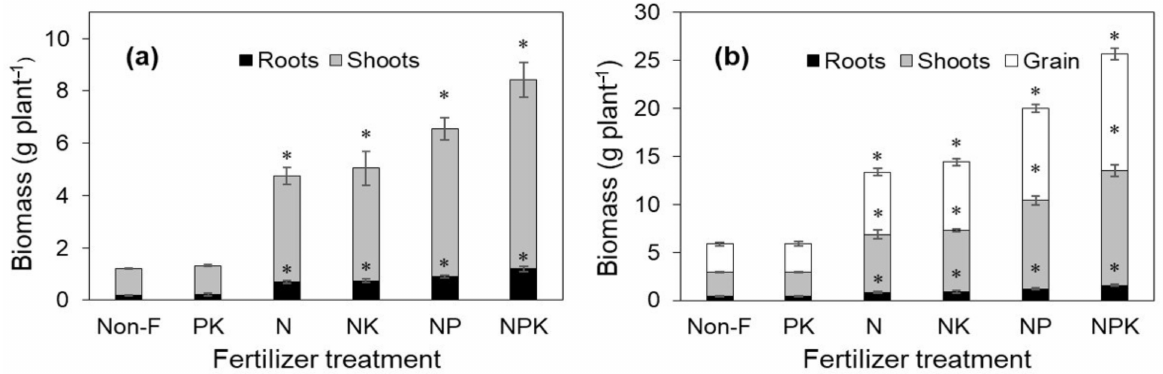
Figure 1. Destructively measured biomass of shoot, root, and grain per plant from different treatments at 42 d after transplanting ( a ) and 102 d after transplanting ( b ). Vertical bars indicate ± SE ( n = 3); * represents a statistically significant difference ( p < 0.05) compared with the no fertilizer treatment. Adding N significantly decreased the root to shoot ratio ( p < 0.05), regardless of whether P and K were applied (Table 2). Addition of P fertilizer further decreased the root to shoot ratio when N was present, but it was not